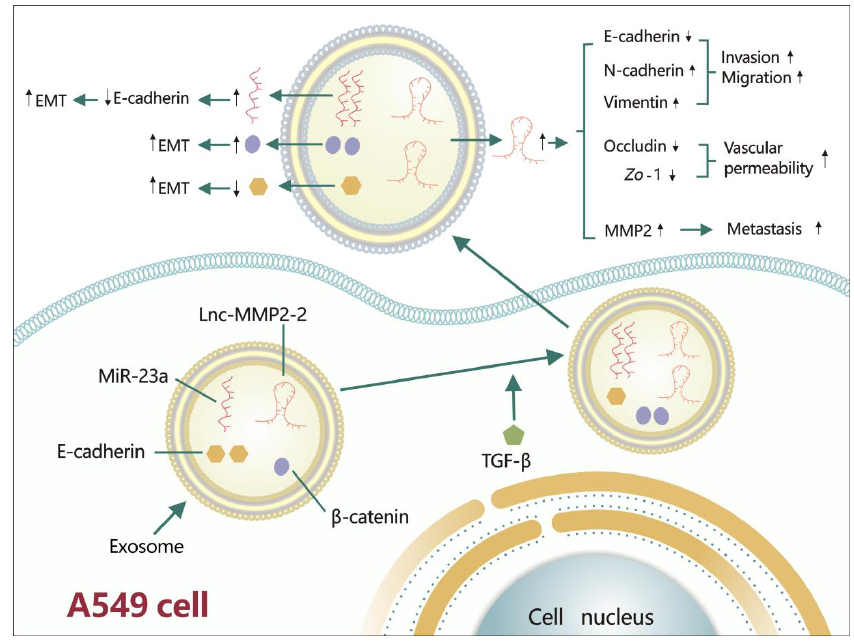
Figure 3. TGF-β regulates lung cancer metastasis via exosomes. TGF-β can affect lung tumor cell invasion, migration, and metastasis by modulating the cargo carried by A549 cell-derived exosomes. In this process, TGF-β can decrease E-cadherin and increase β-catenin, miR-23a and lnc-MMP2-2. Decreased E-cadherin and increased β -catenin can then promote EMT. Increased miR-23a can decrease E-cadherin to enhance EMT. Up-regulated lnc-MMP2-2 can inhibit E-cadherin, as well as increase N-cadherin and vimentin to promote invasion and migration; it can also increase vascular permeability by repressing occludin and Zo-1. Moreover, lnc-MMP2-2 can augment MMP2 to accelerate